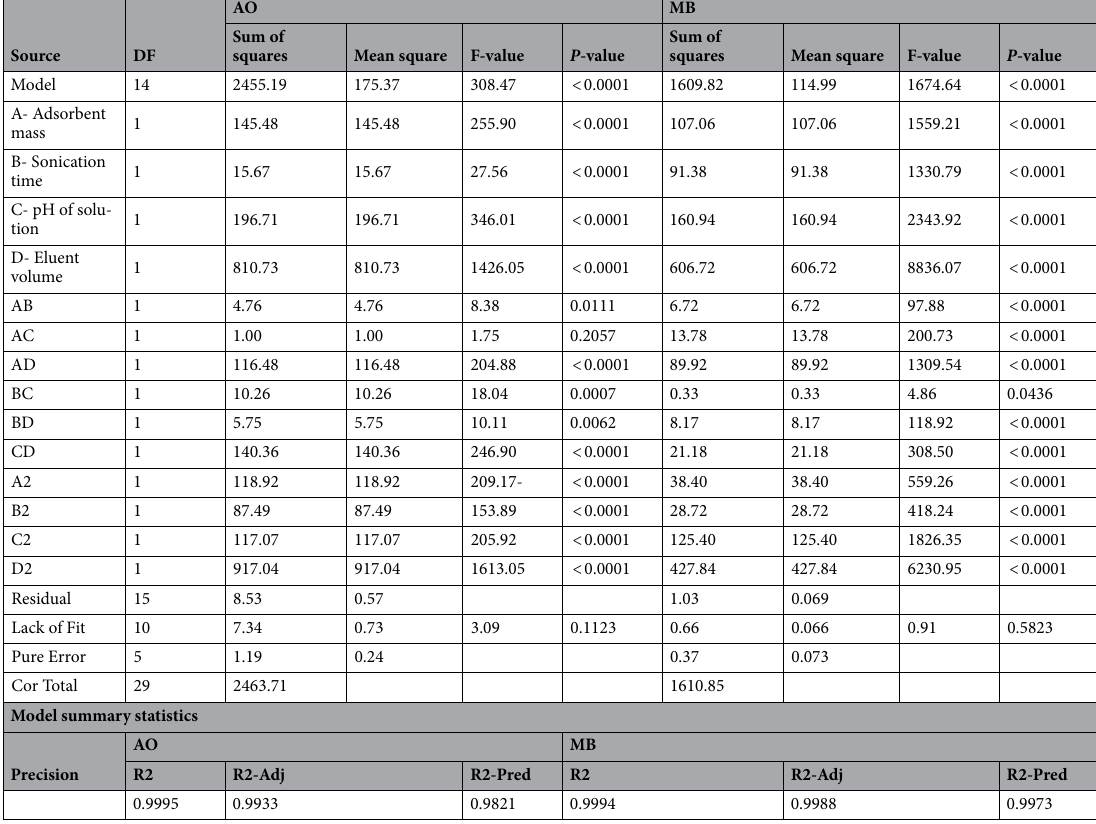
Table 3. Analysis of variance (ANOVA) of remove AO and MB.